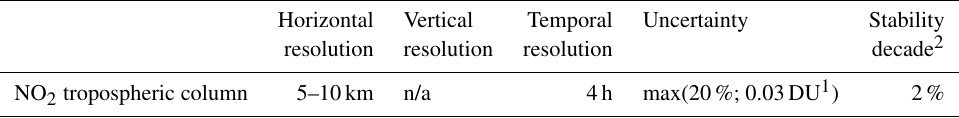
Table 1. GCOS requirements for satellite retrievals of tropospheric NO 2 columns (WMO, 2011). Horizontal Vertical Temporal Uncertainty Stability resolution